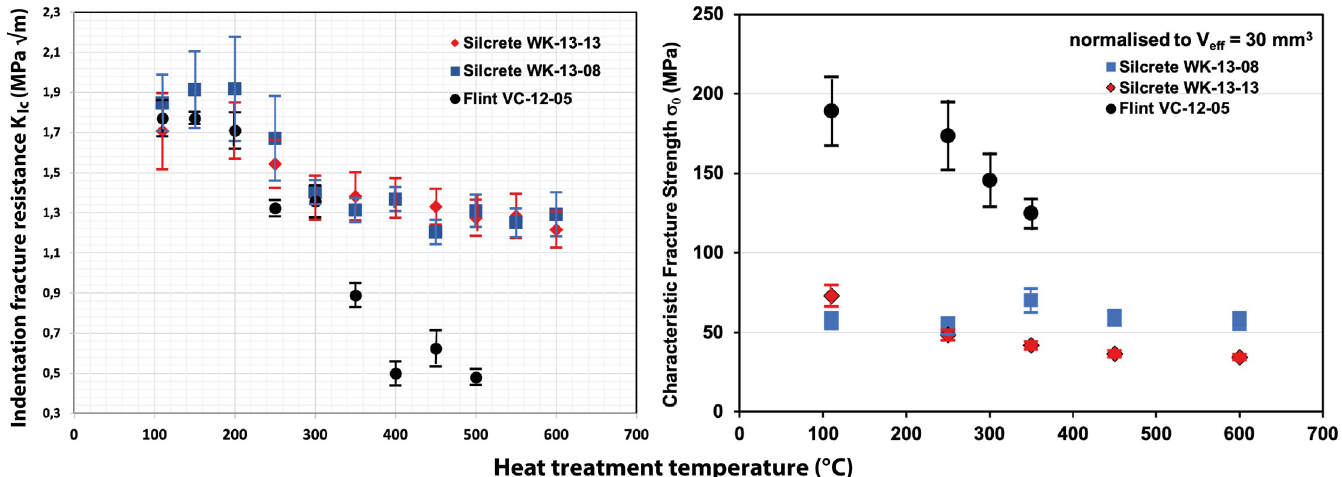
Fig 1. Plot of indentation fracture resistance K values in (a) are also reported for those temperature steps for which no σ 0 is available. The error bars in (b) are taken directly from the corresponding data tables of Schmidt et al. [19], from which σ 0 is